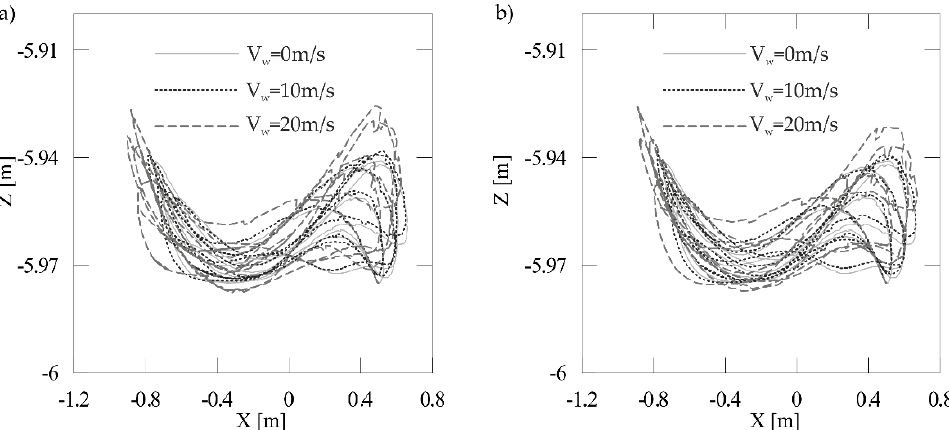
Figure 11. Projection of the trajectory of the carried load’s suspension point on one of the lifting planes for ( a ) the variable effective area and ( b ) fixed effective area.